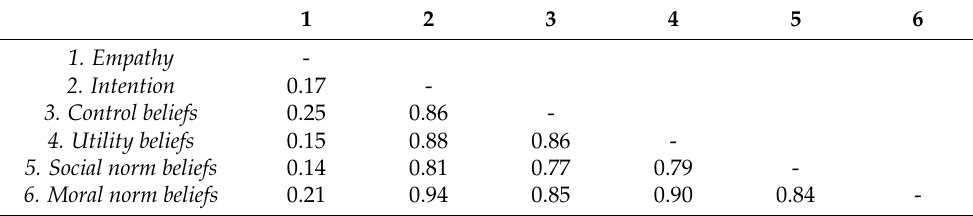
Table 2. Heterotrait-monotrait ratio of correlations for Study 1.